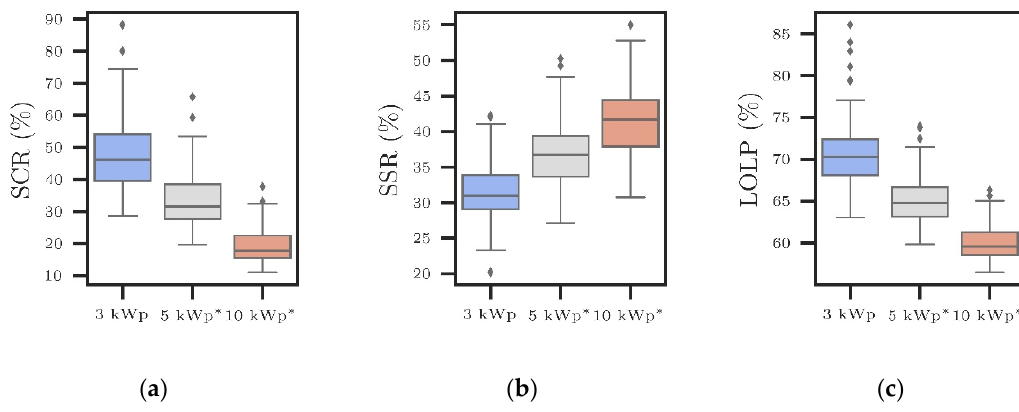
Figure 9. Load matching indicator values for different rooftop PV capacities; ( a ) SCR; ( b ) SSR; ( c ) LOLP (n = 55). (* upscaled from 3 kWp PV generation